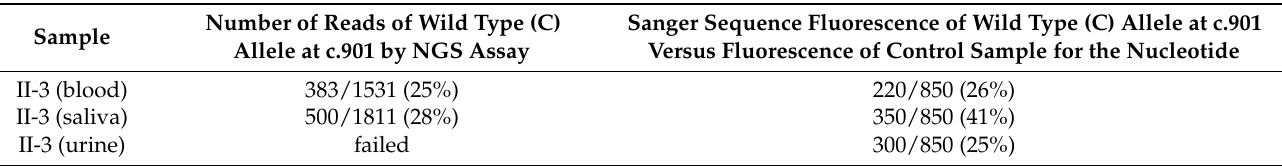
Table 1. Assessment of levels of C (wild type) allele at GLA position 901 by NGS assay and Sanger sequencing in DNA derived from blood, saliva, and urine.